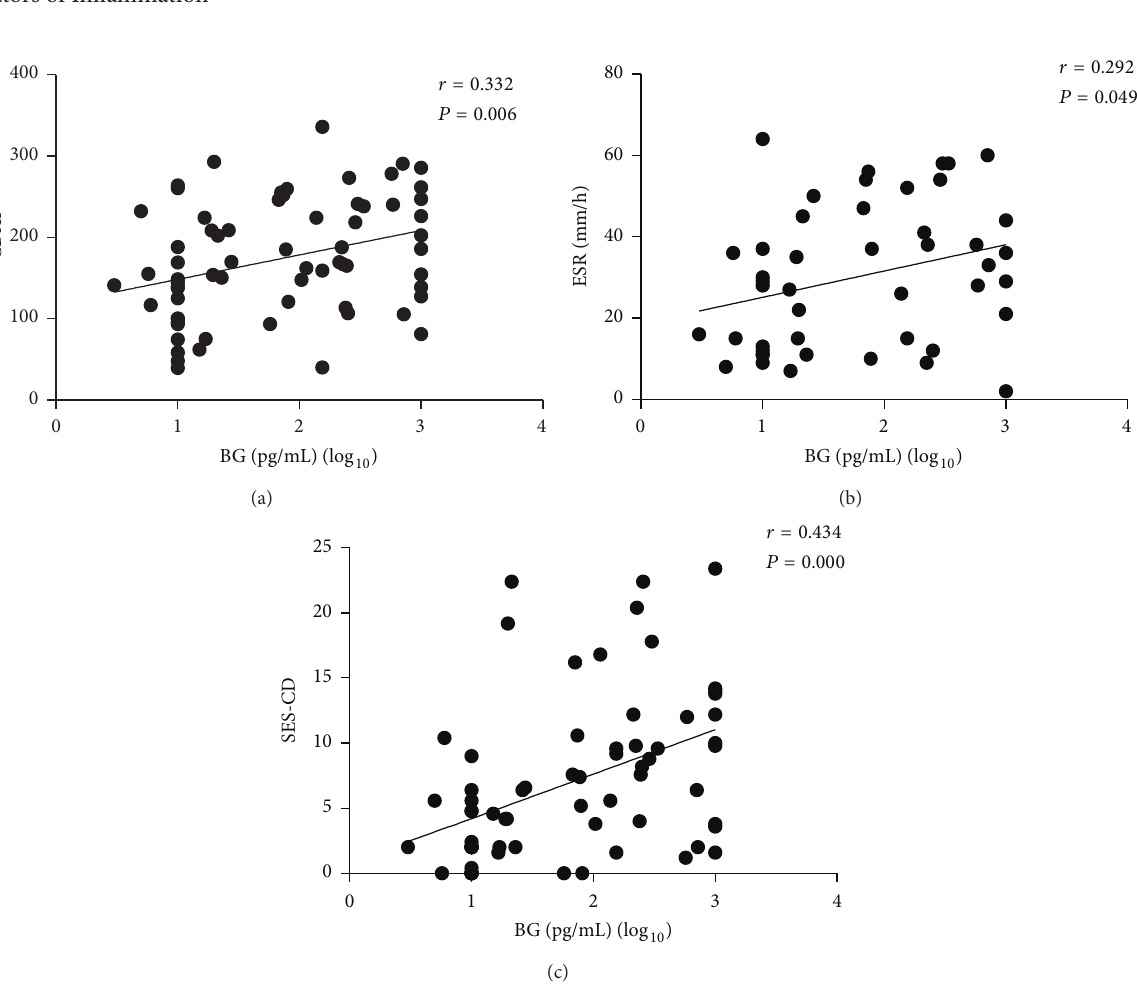
Figure 3: Correlation analysis among CDAI, ESR, and SES-CD and the levels of BG in CD patients. Correlation between CDAI and BG ((a), 𝑟 = 0.332 , 𝑃 = 0.006 ) in all CD patients. Correlation between ESR and BG ((b), 𝑟 = 0.292 , 𝑃 = 0.049 ) in all CD patients. Correlation between SES-CD and BG ((c), 𝑟 = 0.434 , 𝑃 = 0.000 ) in all